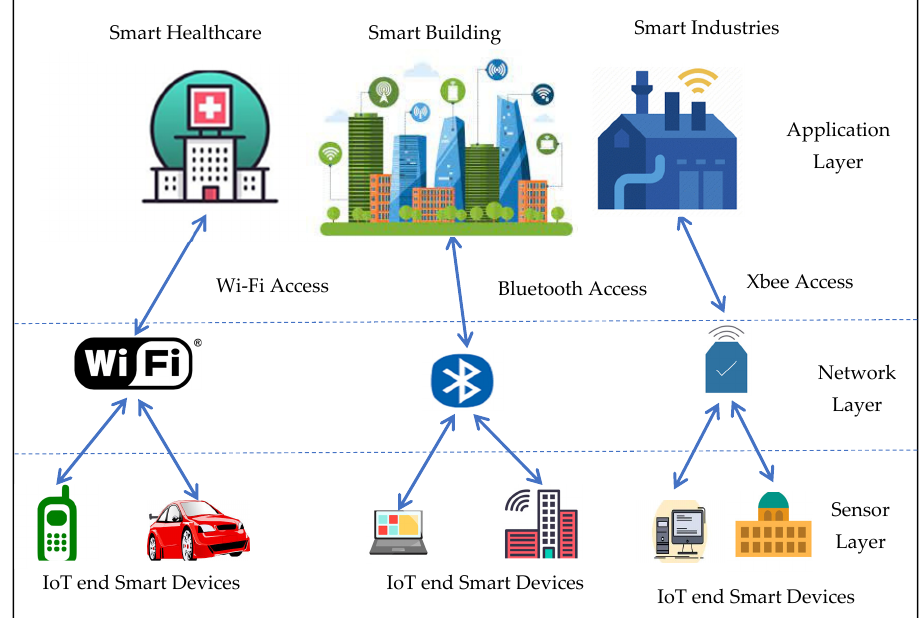
Figure 1. IoT architecture [36] .